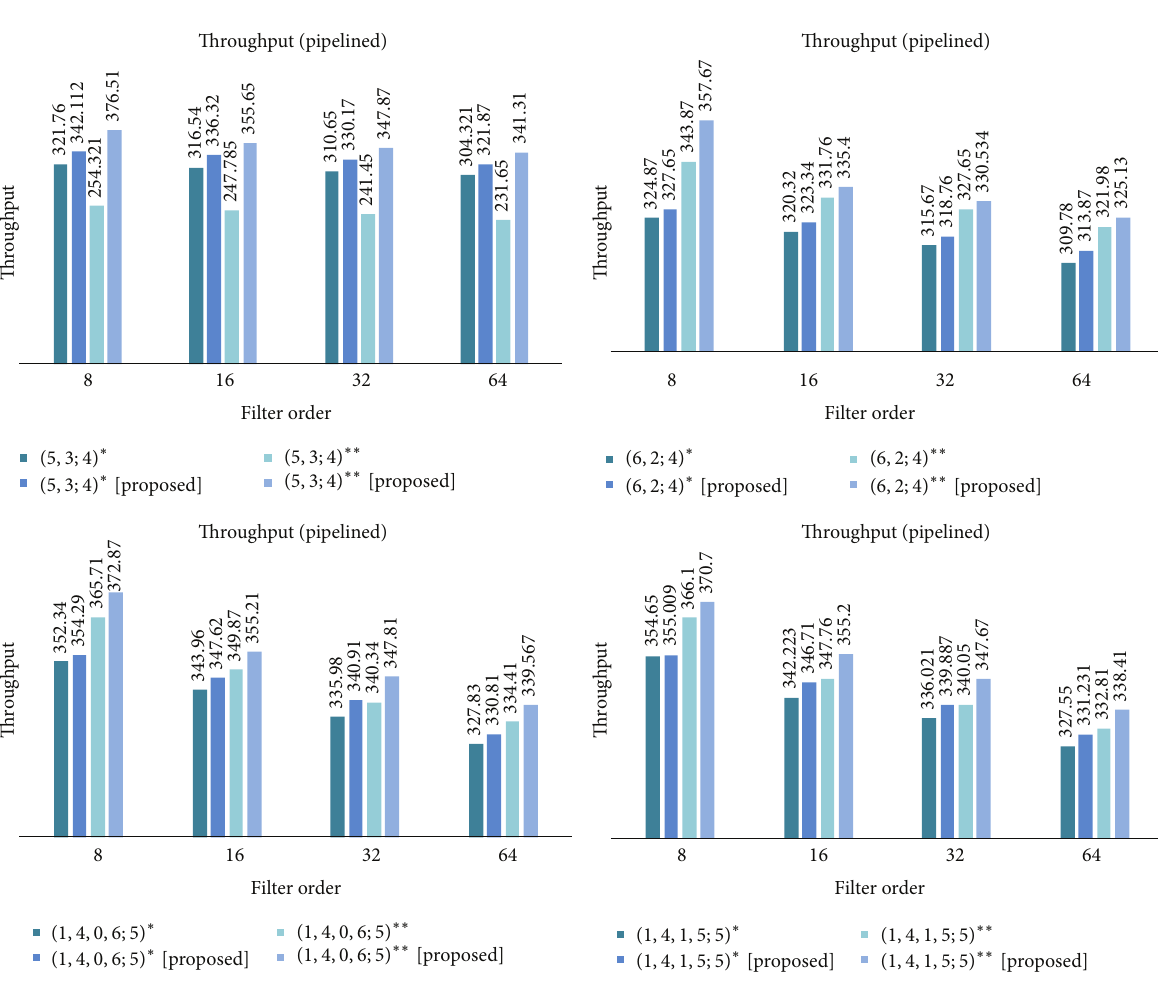
Figure 16: Throughput (in MHz) for filters based on different GPCs on Kintex-7